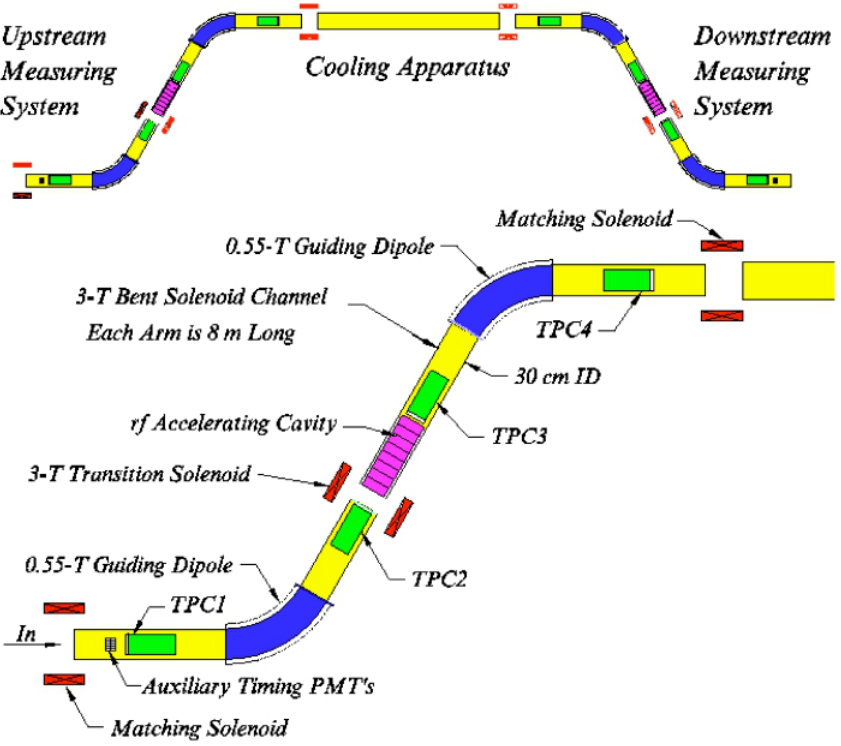
FIG. 37. (Color) Schematic of the cooling test apparatus